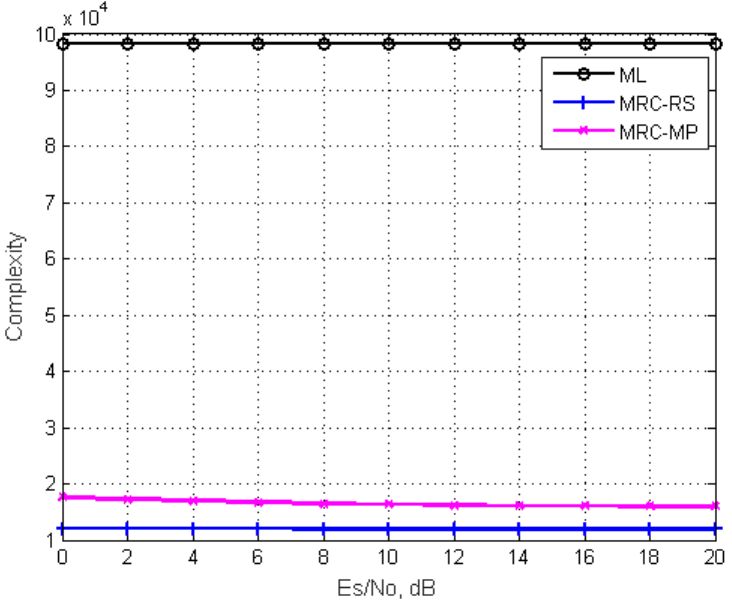
Figure 10. Comparison of the computational complexity of the proposed detectors and the ML detector for a GSM system with N t = 16, N r = 16, M = 16 and N p =